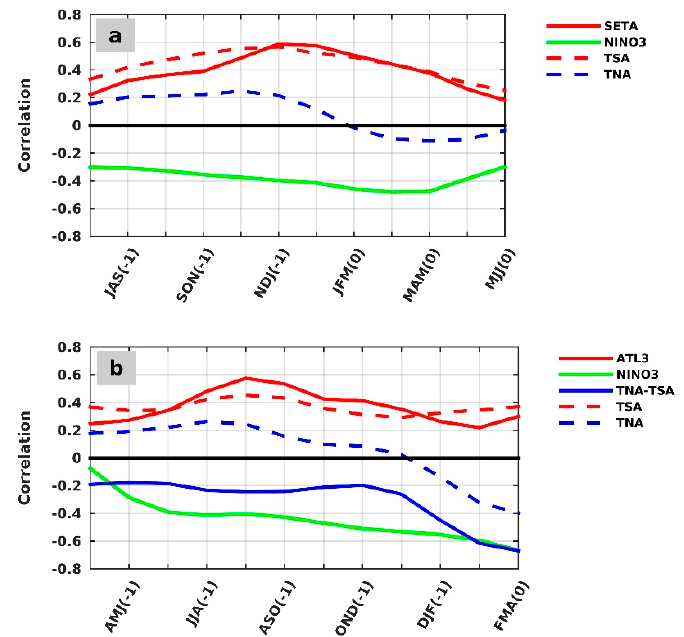
Figure 8. Seasonal evolution of the lagged linear correlation coefficient between ( a ) MJJ rainfall anomalies in Eastern NEB and the SETA (red line), the NINO3 (green line), the tropical South Atlantic (TSA, 20 ◦ S–0 ◦ ; 40 ◦ W–15 ◦ E, red dashed line), and the tropical North Atlantic (TNA, 0 ◦ –20 ◦ N; 60 ◦ –15 ◦ W, blue dashed line) SSTA for the period 1980–2015, ( b ) FMA rainfall anomalies in Northern NEB and the ATL3 (red line), the NINO3 (green line), the Atlantic dipole (blue line; tropical North Atlantic—tropical South Atlantic (TNA-TSA)), the TSA (red dashed line), and the TNA (blue dashed line) SSTA for the period 1980–2015. Correlations higher than ± 0.32 are significant at a 95% confidence level, according to the t -test, for ( a ) and ( b ).